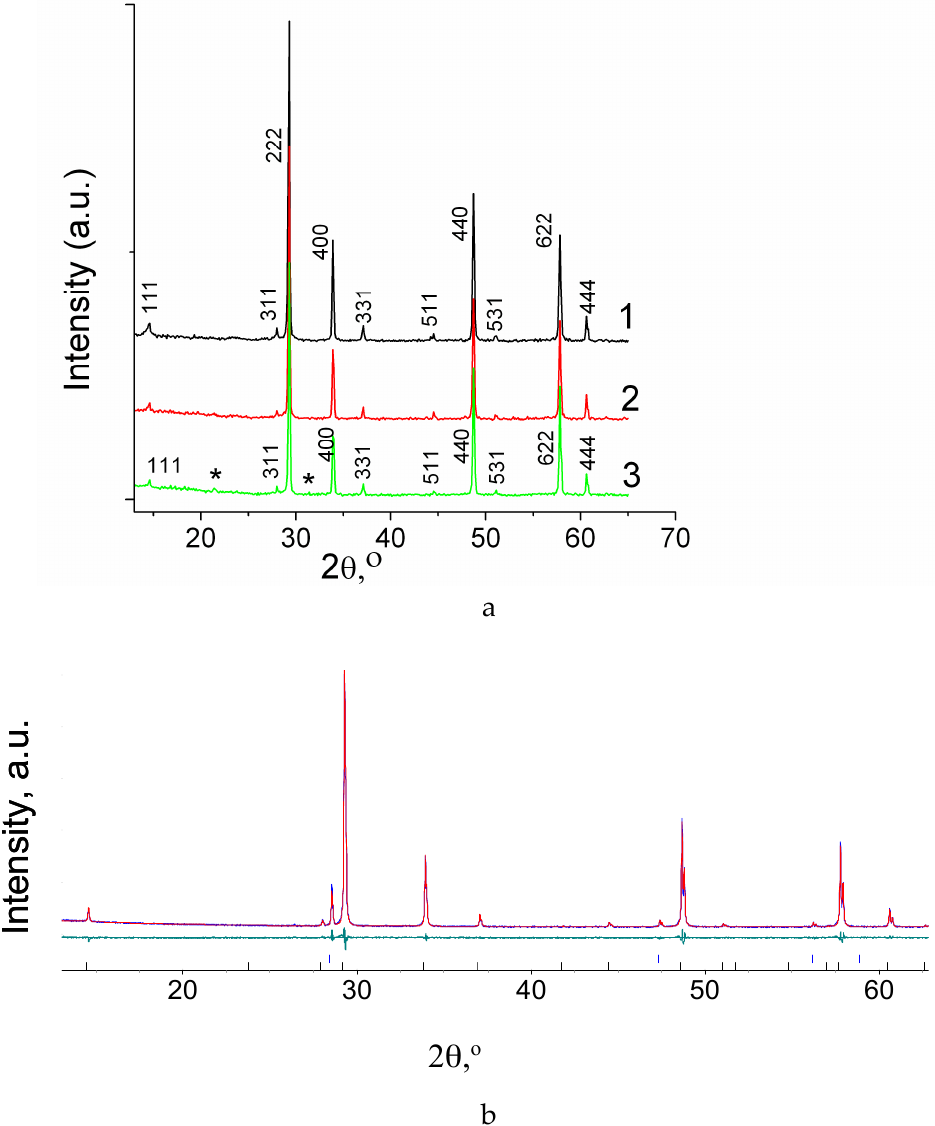
Figure 1. ( a ) XRD patterns of the Sm 2 − x Ca x Zr 2 O 7 − x / 2 (1) x = 0, (2) x = 0.05, (3) x = 0.1; ( b ) Rietveld data of Sm 2 − x Ca x Zr 2 O 7 − x / 2 (x = 0.05) XRD pattern: the measured (blue line), the calculated (red line), the di ff erence between measured and calculated data (green line). Vertical bars show calculated reflections for di ff erent phases Sm 1.95 Ca 0.05 Zr 2 O 6.975 (lower) and Si internal standard (upper). R wp = 3.36%, R p = 4.49%, R exp = 3.47%, GOF = 1.34.